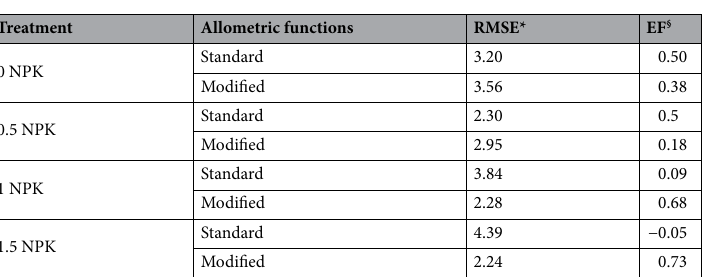
Table 3. Values of root mean square error (RMSE, t C ha −1 ) and model efficiency (EF) for simulated top SOC of each treatment. *RMSE values can range from 0 (representing complete match) to + ∞. § Values for EF range from -∞ to 1 (representing perfect model). A positive EF value indicates that the simulated values describe the variation in the measured data better than the mean of the observations. A negative value indicates that the simulated values describe the data less well than a mean of the